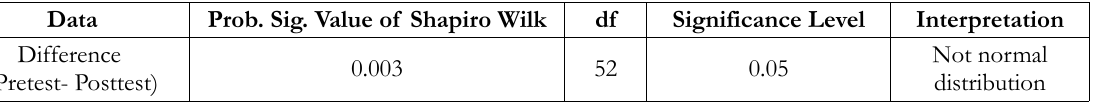
Table 8. The result of prerequisite test